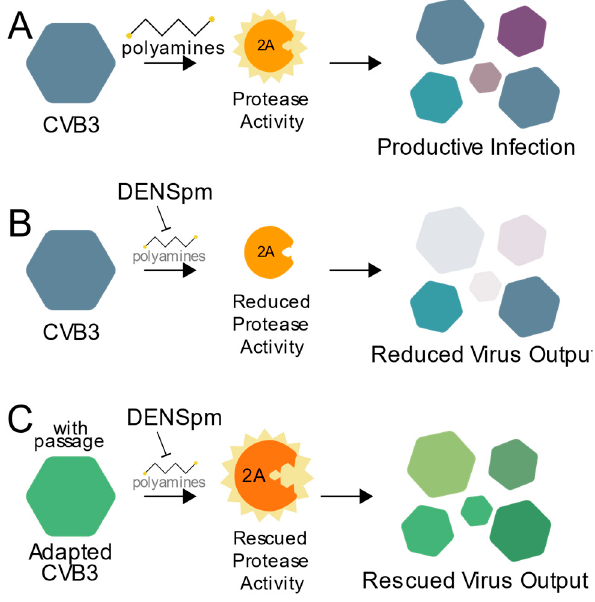
Figure 6. Working model. ( A ) CVB3 relies on polyamines for efficient 2A protease activity to promote viral replication. In the presence of an inhibitor of polyamines, like DENSpm ( B ), protease activity and viral replication are reduced. ( C ) CVB3 overcomes polyamine depletion over successive rounds of replication via mutation of the 2A protease to facilitate rescued virus replication.